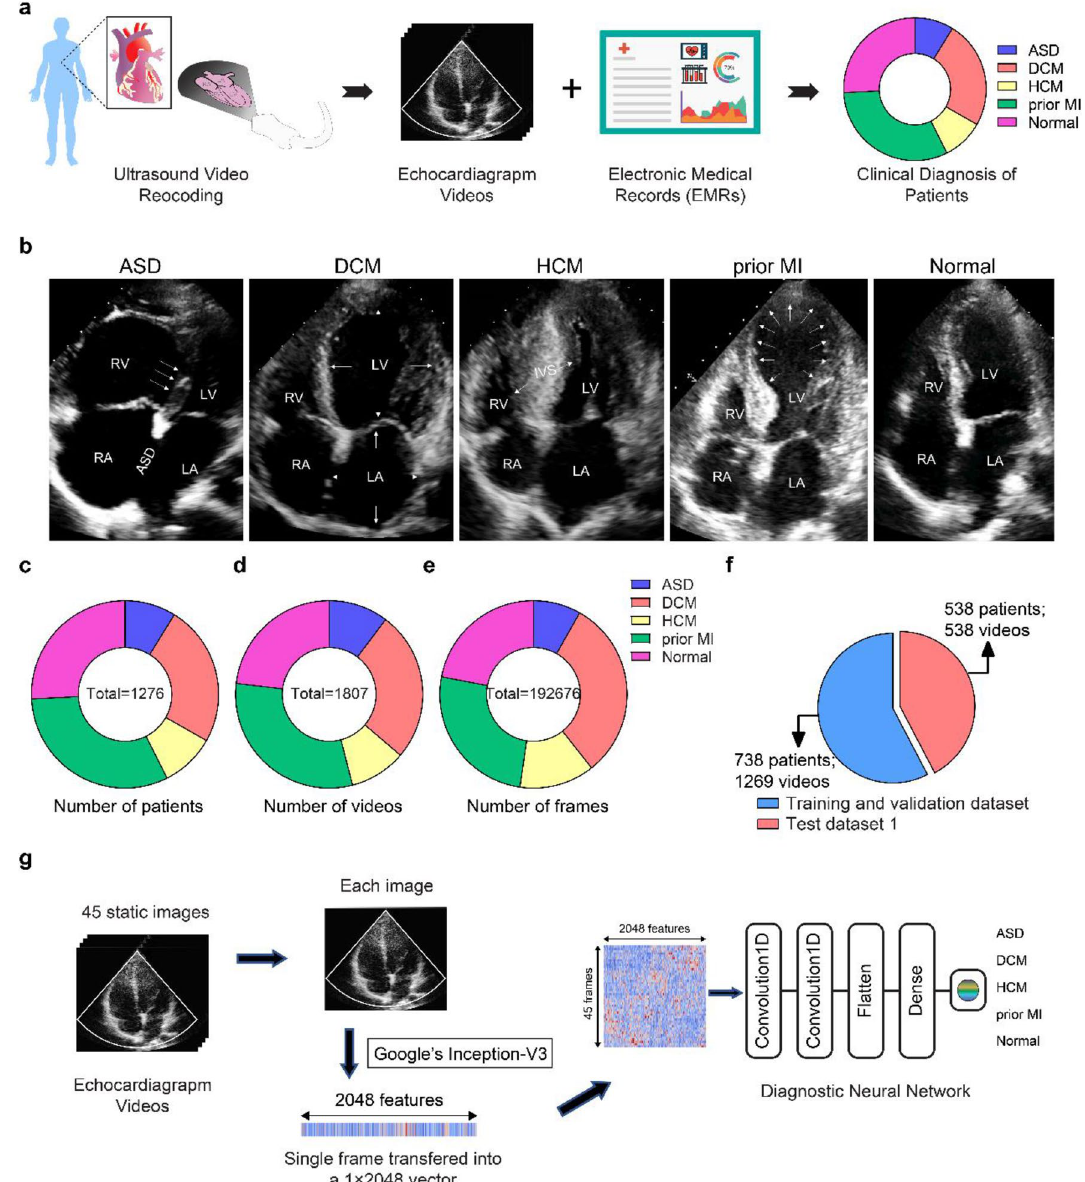
Figure 1. Overview of the study design of AIEchoDx. ( a ) The echocardiogram videos and corresponding electronic medical records were collected for five diagnostic classes, including atrial septal defect (ASD), dilated cardiomyopathy (DCM), hypertrophy cardiomyopathy (HCM), prior myocardial infarction (prior MI), and normal subjects (Normal). ( b ) Examples of apical 4-chamber view (A4c) images of ASD, DCM, HCM, prior MI, and Normal (LV, left ventricle; LA, left atrium; RV, right ventricle; RA, right atrium). The white arrows displayed the morphology changes and disease hallmarks for clinical diagnosis. ( c – e ) The distributions of patients ( c ), videos ( d ), and single A4c slice per class ( e ) in the echocardiography dataset to train the deep neural network. ( f ) The distributions of the training, validation dataset, and test dataset 1. ( g ) The architecture of the AIEchoDx framework for analyzing echocardiogram